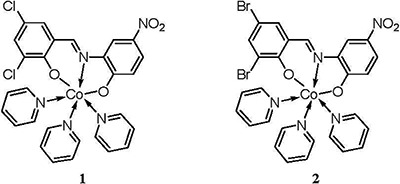
Scheme representation of compounds Py3CoL1 (1) and Py3CoL2 (2).